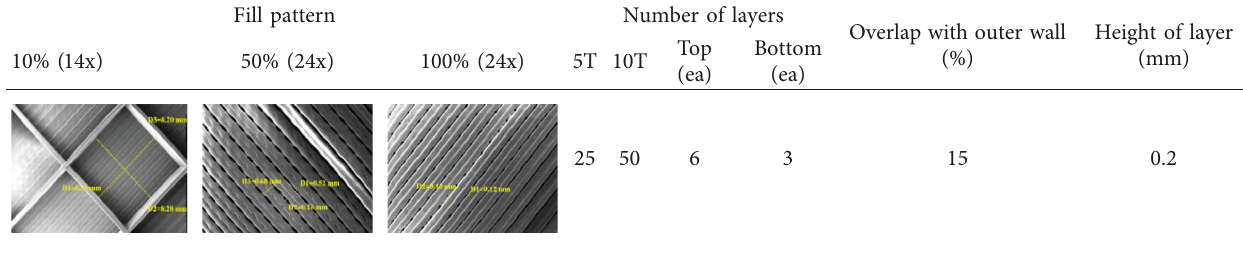
Table 1: Detailed conditions of 3D printing.